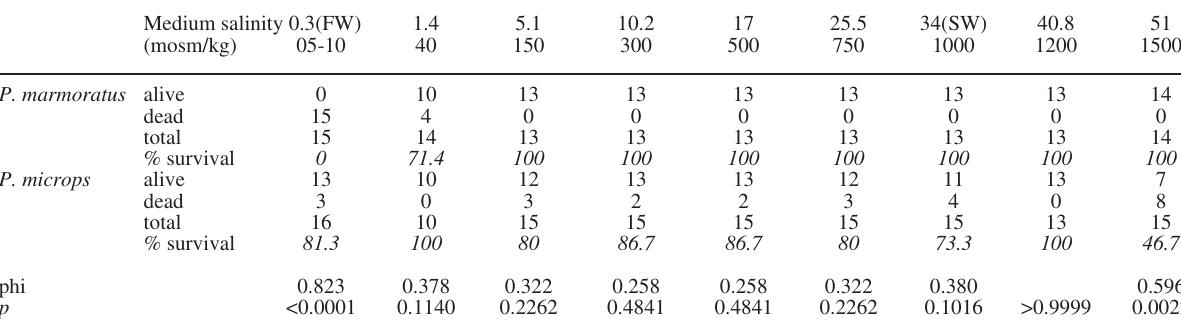
Table 2. – survival rate (%) of Pomatoschistus microps and P. marmoratus after 4 day-exposure to different media (eXP2), with 10-16 individuals at the start of each experiment and significance of the inter-species differences (Fisher’s exact method). FW = freshwater; sW = sea water.